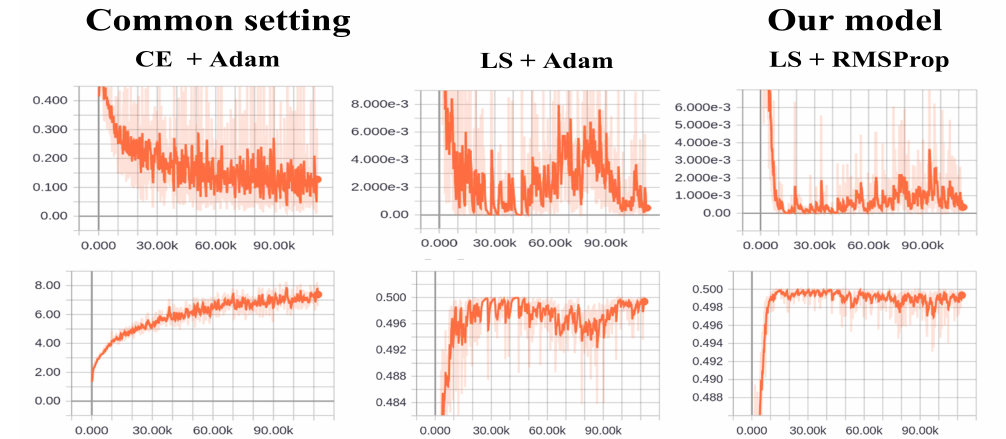
Figure 6. The loss curves of our model and two different combinations (loss + optimizer). The first row presents the loss of the discriminator and the second row presents the loss of the generator. The X axis represents the number of training steps, and the Y axis represents the loss values. Our model has a fast convergence and smooth loss curves for both the generator and discriminator among all combinations.